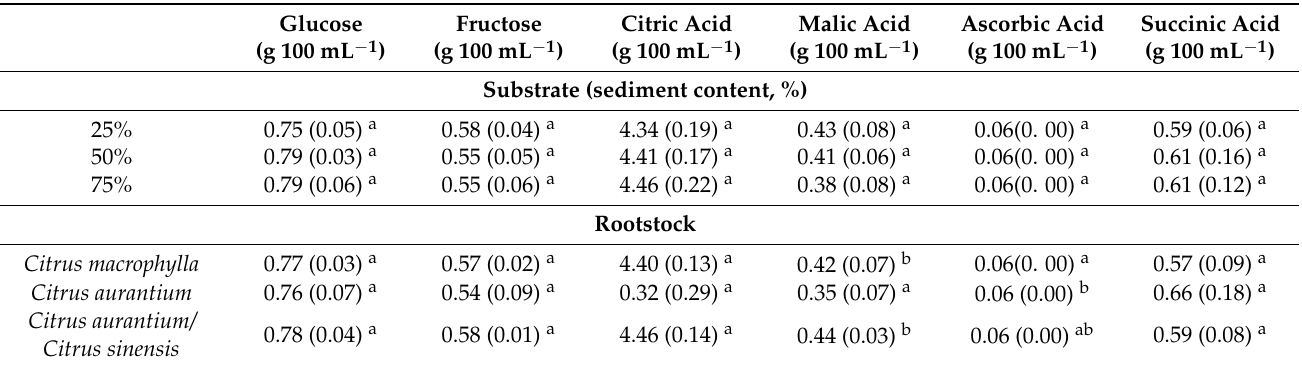
Table 7. Sugars and organic acids (g 100 mL − 1 ) identified in the juice of ‘Verna’ lemon grown with different rootstocks and substrates. The results represent the mean values ( n = 5) and their standard deviation in